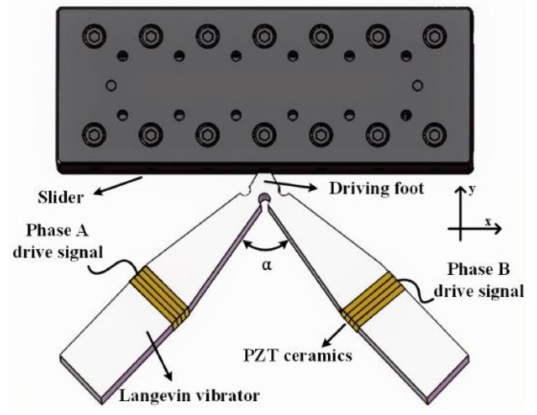
Figure 1. Structure of the V-type linear ultrasonic